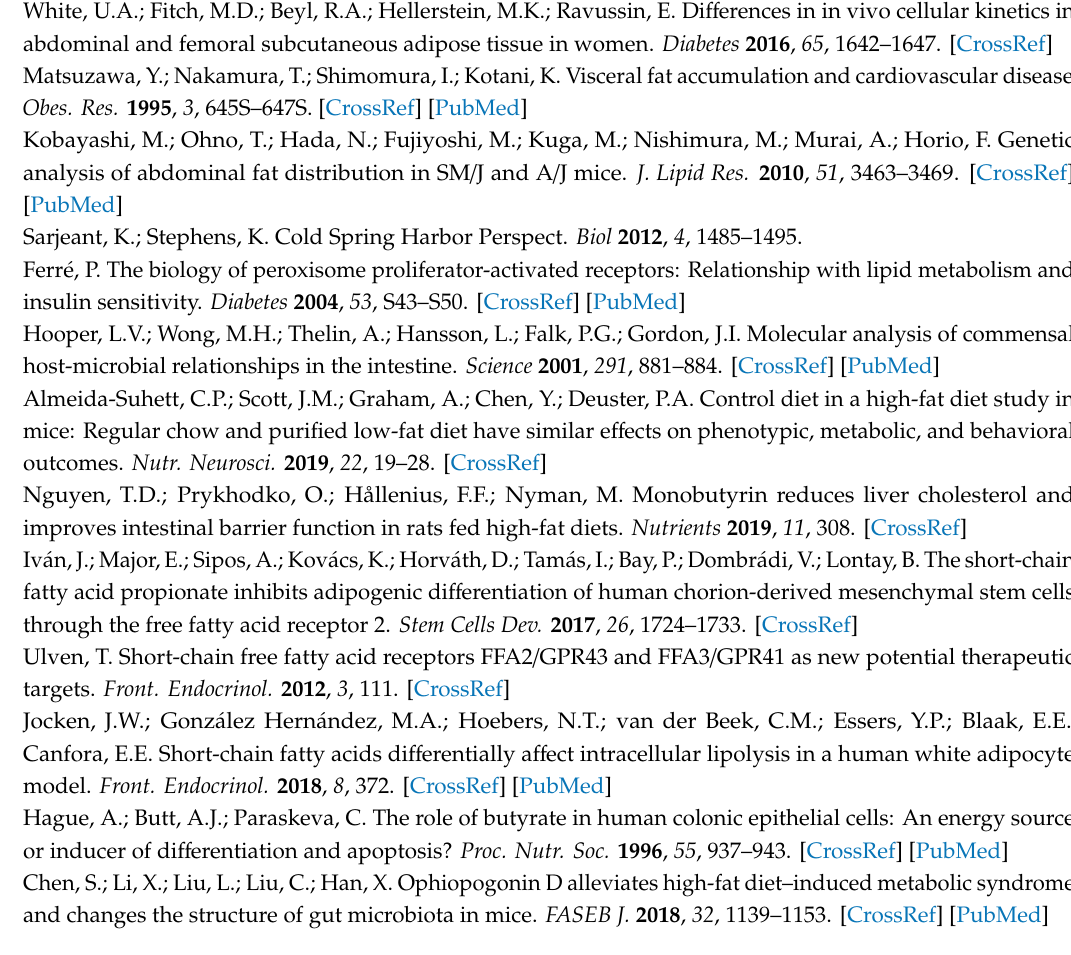
Figure S1: E ff ect of L. mesenteroides EH-1 on HFD-induced weight gain in mice. Figure S2: Involvement of Ffar2 in down-regulation of PPAR- γ by L. mesenteroides EH-1 in the di ff erentiated 3T3-L1